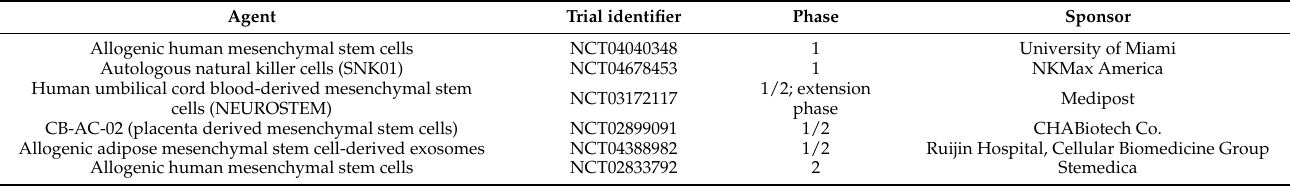
Table 4. Stem cell therapies for Alzheimer’s disease in clinical trials